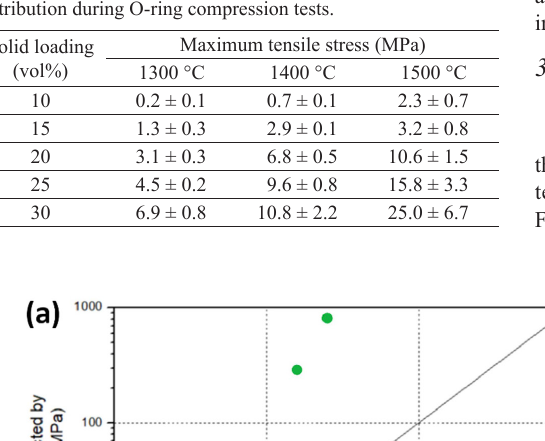
Figure 7. (a) Relationship between the maximum stress supported by the honeycomb structure under traction in the X and the maximum tangential stress achieved in the O-ring test for samples sintered at 1500 °C. (b) Schematic representation of tangential stresses directions acting perpendicular to the pore structure due to the radially aligned ice crystal